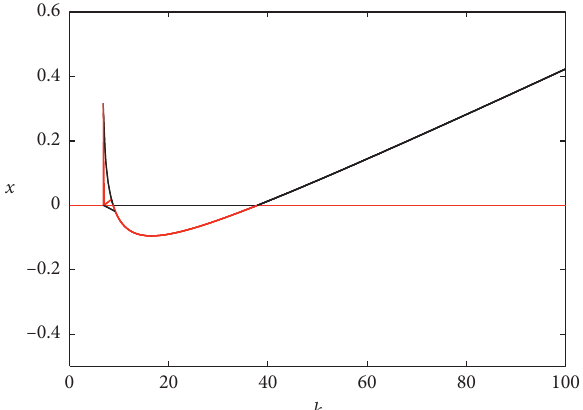
Figure 15: The bifurcation diagram of k i . The black line indicates that the equilibrium point of the system is unstable, and the red line indicates that the equilibrium point is stable.